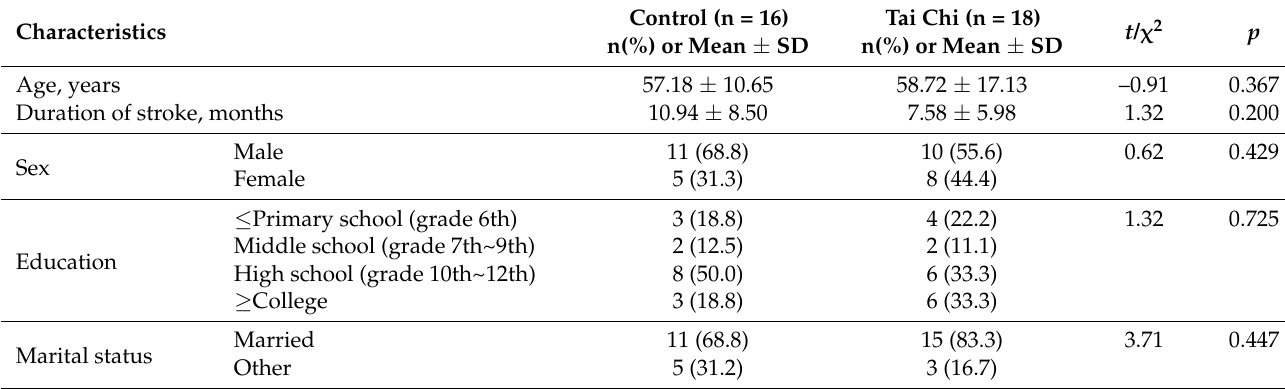
Table 1. Result from homogeneity of the general characteristics at baseline ( N =